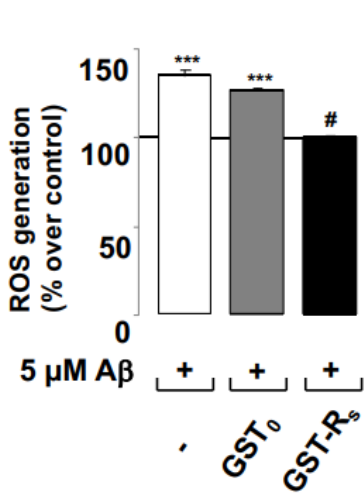
Figure 1. R s peptide, carrying the signal peptide of integrin β 1, specifically binds to A β peptide and blocks A β -induced ROS production in primary astrocyte cultures. ( A ) Schematic representation of the structure of integrin β 1with its different extracellular regions. ( B ) Interaction of synthetic A β peptide with the indicated GST fusion proteins, GST 0 , GST-R t , GST-R d , GST-R w , and GST-R t . After incubation, glutathione beads were washed and proteins separated by SDS-PAGE under non-reducing conditions and analyzed by Western blot using anti-A β 1–42 antibody (6E10, from Covance). ( C ) ROS generation was measured by fluorimetry with 10 µM CM-H2DCFDA. Data are expressed as the relative fluorescence normalized to values of untreated or treated cells (100%). *** p < 0.001 compared to non-treated cells; # p < 0.05 compared to GST 0 ; unpaired one-way ANOVA.